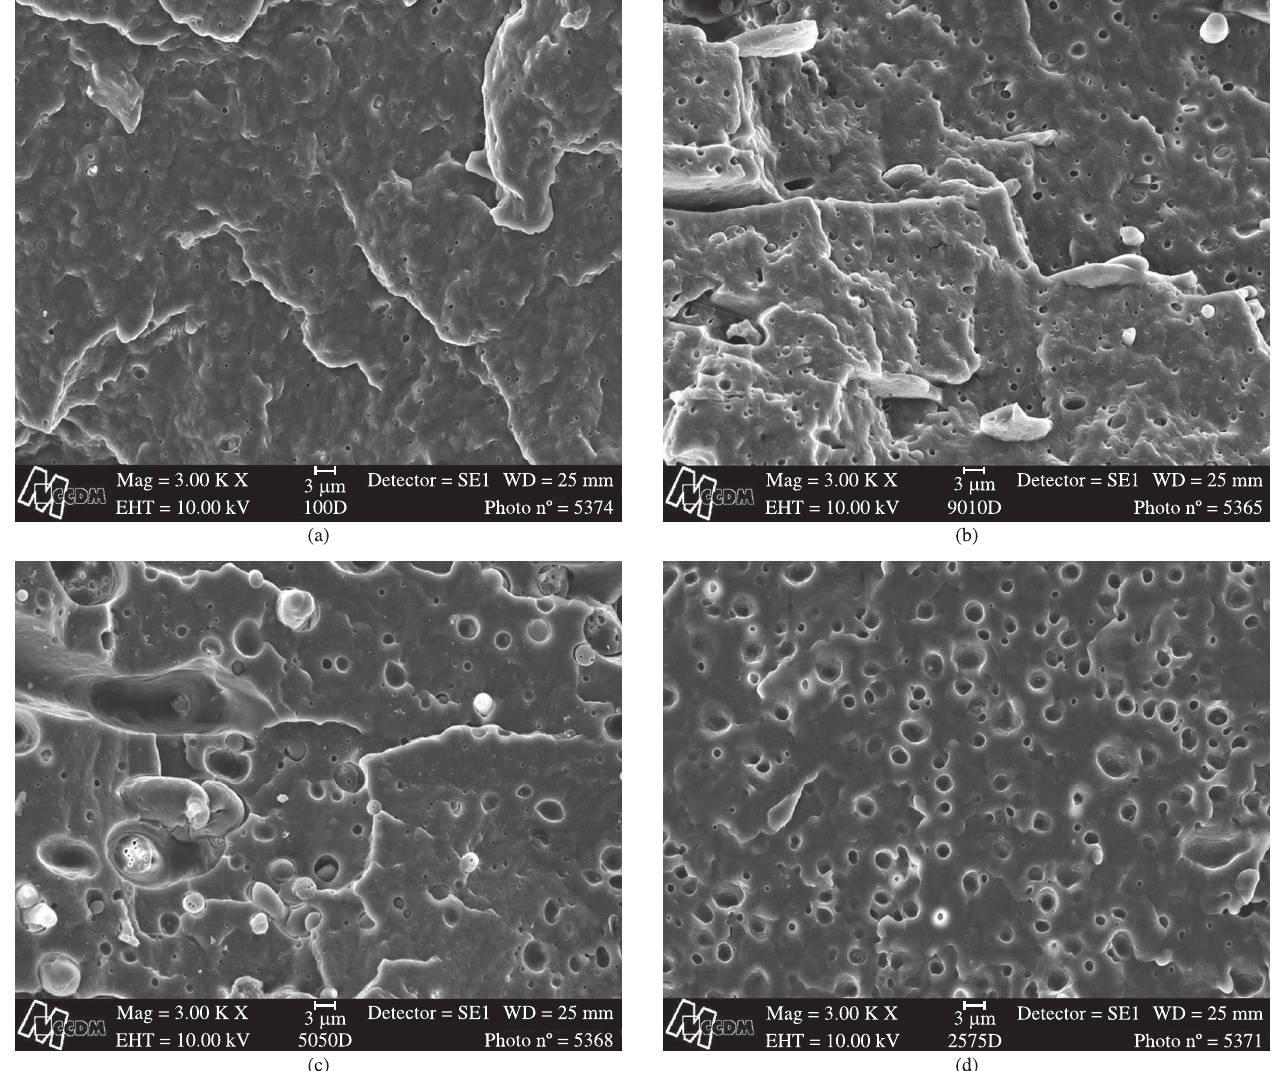
Figure 2. SEM photomicrographs of the fractured surfaces of: a) PHB; b) PHB/PP (90/10); c) PHB/PP (75/25); and d) PHB/PP (50/50). 3,000 x